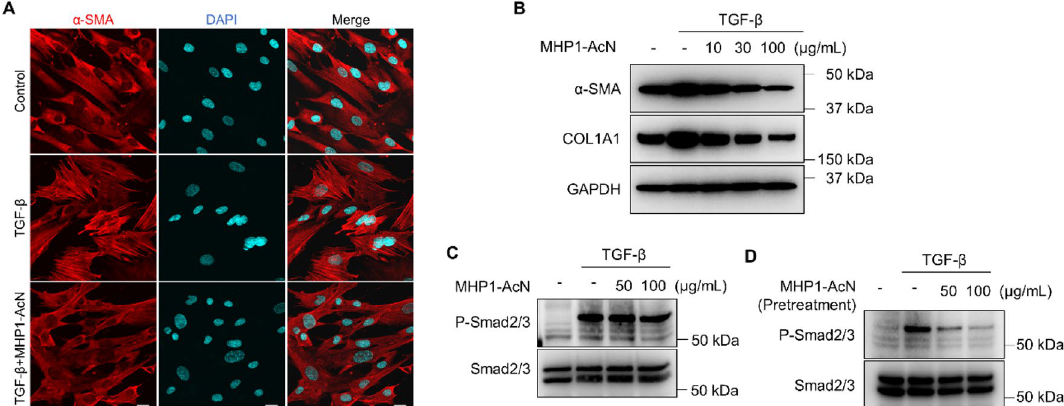
Figure 4. MHP1-AcN inhibited TGF-β1-induced myofibroblast differentiation and Smad2/3 phosphorylation in fibroblasts. ( A ) MRC-5 cells treated with TGF-β1 (5 ng/mL) with or without MHP1-AcN (50 µg/mL) for 48 h were stained with anti-α-SMA and DAPI and viewed by confocal microscopy. Bar = 20 µm. ( B ) MRC-5 cells were treated with TGF-β1 (5 ng/mL) with or without MHP1-AcN (10, 30 or 100 µg/mL) for 48 h, the α-SMA and COL1A1 levels were analyzed by western blotting. ( C ) MRC-5 cells were simultaneously treated with TGF- β1 (2 ng/mL) and MHP1-AcN (50 or 100 µg/mL) for 30 min, the Smad2/3 phosphorylation was evaluated by western blotting. ( D ) MRC-5 cells were pretreated with MHP1-AcN (50 or 100 µg/mL) for 24 h, then incubated with TGF-β1 (2 ng/mL) for 30 min. Smad2/3 phosphorylation was evaluated by western blotting. Experiments were repeated at least twice.